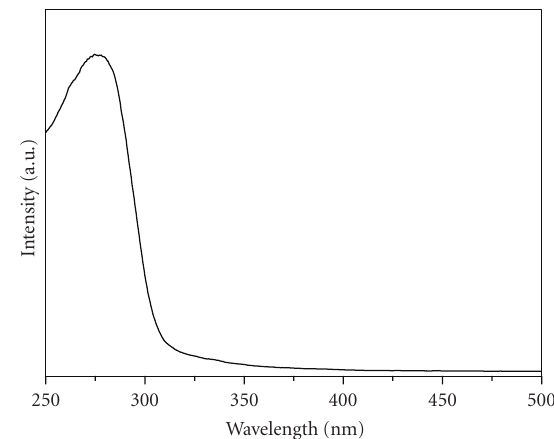
Figure 8: Di ff use reflectance spectra of the NaTaO 3 powder synthe- sized by spray pyrolysis (mean residence time = 1.80 seconds, spray pyrolysis temperature = 1173 K, precursor preparation temperature = 333K, precursor concentration = 0.125 M, carrier gas (air) flow rate = 5L/min, Na/Ta = 1.00).